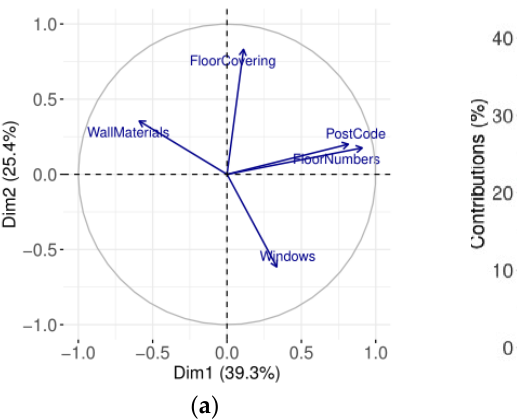
( b ) Figure 7. Results of the second PCA analysis : ( a ) the correlation circle and ( b ) Percentage contribu- tions of the factors that formed the main components (see Table 1). Two factor maps were made with a subset of the values: one highlighting the floor covering (Figure 8a) and the other the wall material (Figure 8b). The first graph shows that wood-panelled floors and most linoleum floors are positively correlated with floor size. The corresponding dwellings have an indoor radon value that is more influenced by floor coverings, as is also shown by the position of wood coverings in the fourth quadrant.